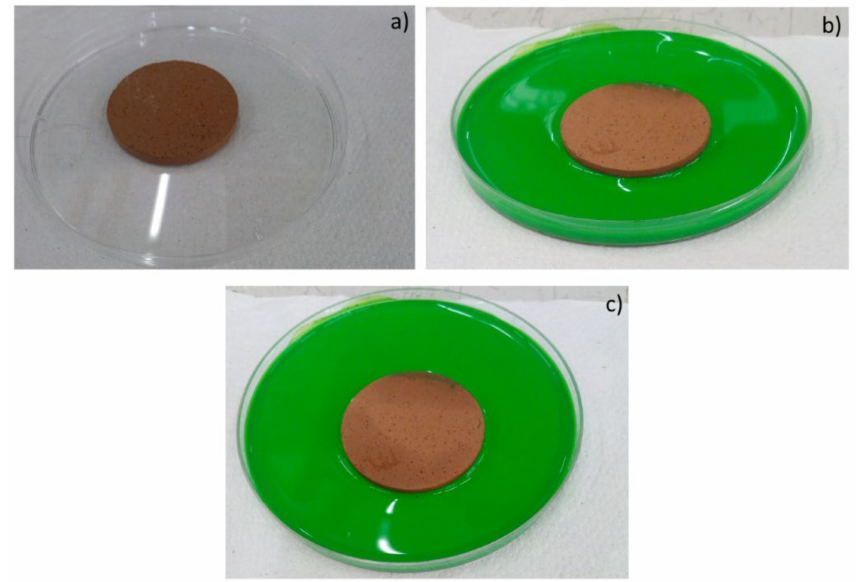
Figure 10. Images of powder-pressed samples (PR.FG30) before the contact with green ink ( a ); 2 s ( b ) and 2 min ( c ) after the contact with green